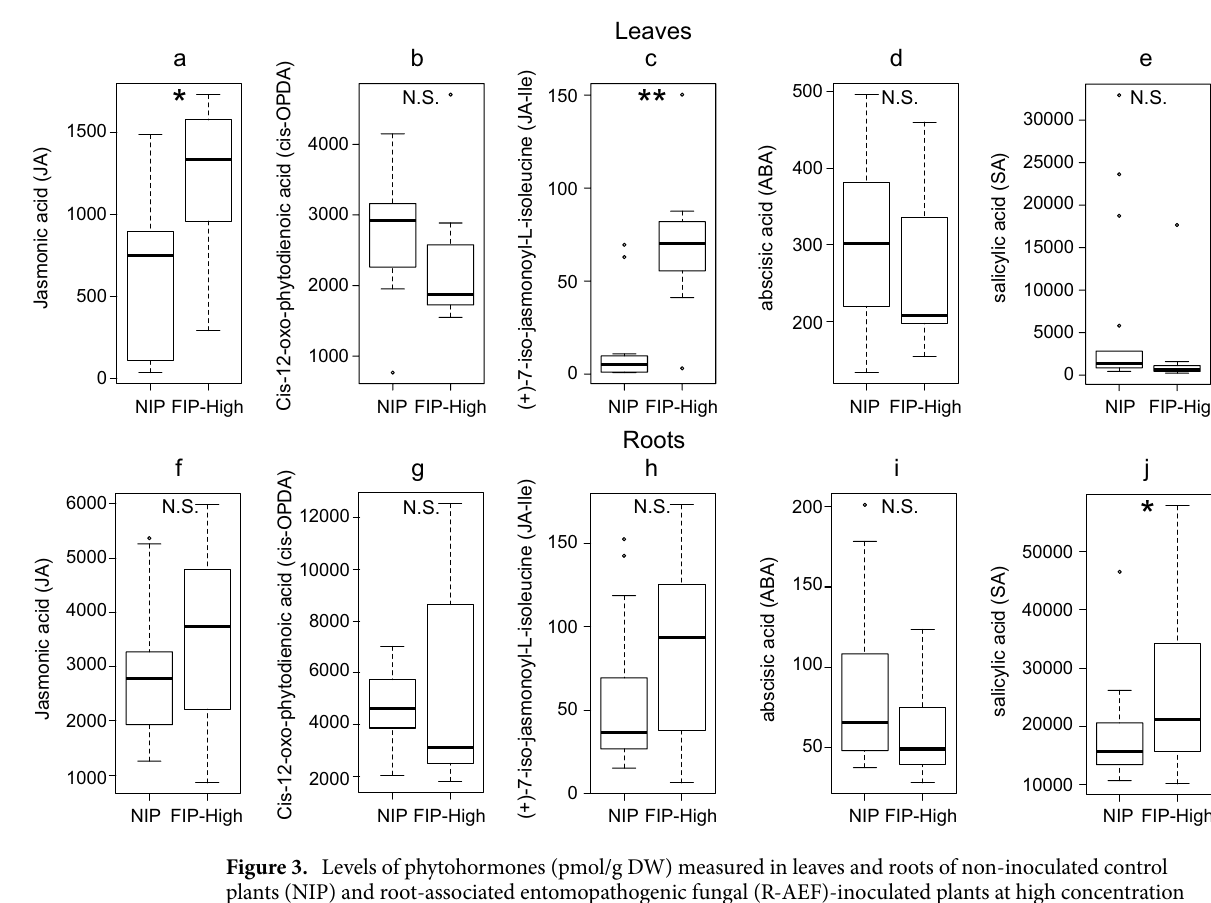
Figure 3. Levels of phytohormones (pmol/g DW) measured in leaves and roots of non-inoculated control plants (NIP) and root-associated entomopathogenic fungal (R-AEF)-inoculated plants at high concentration of fungal inoculum (FIP-High). Boxplots represent phytohormone relative abundances of jasmonic acid (JA), (+)-7-iso-jasmonoyl-l-isoleucine (JA-Ile), cis-12-oxo-phytodienoic acid (cis-OPDA), abscisic acid (ABA) and salicylic acid (SA) measured in leaves ( a – e ) and in root sections ( f – j ). Boxplots visualize five summary statistics (the middle bar = median; box = inter-quartile range; bars extend to 1.5× the inter-quartile range the median). Stars represent *p < 0.05, **p < 0.01, ***p < 0.001, N.S. not